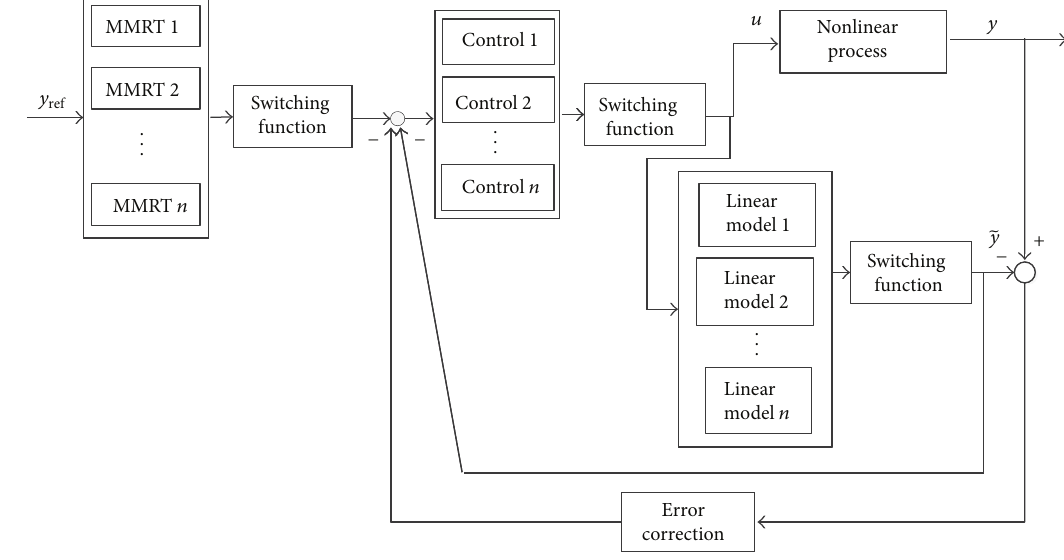
Figure 4: The principle frame of multiple model predictive control.